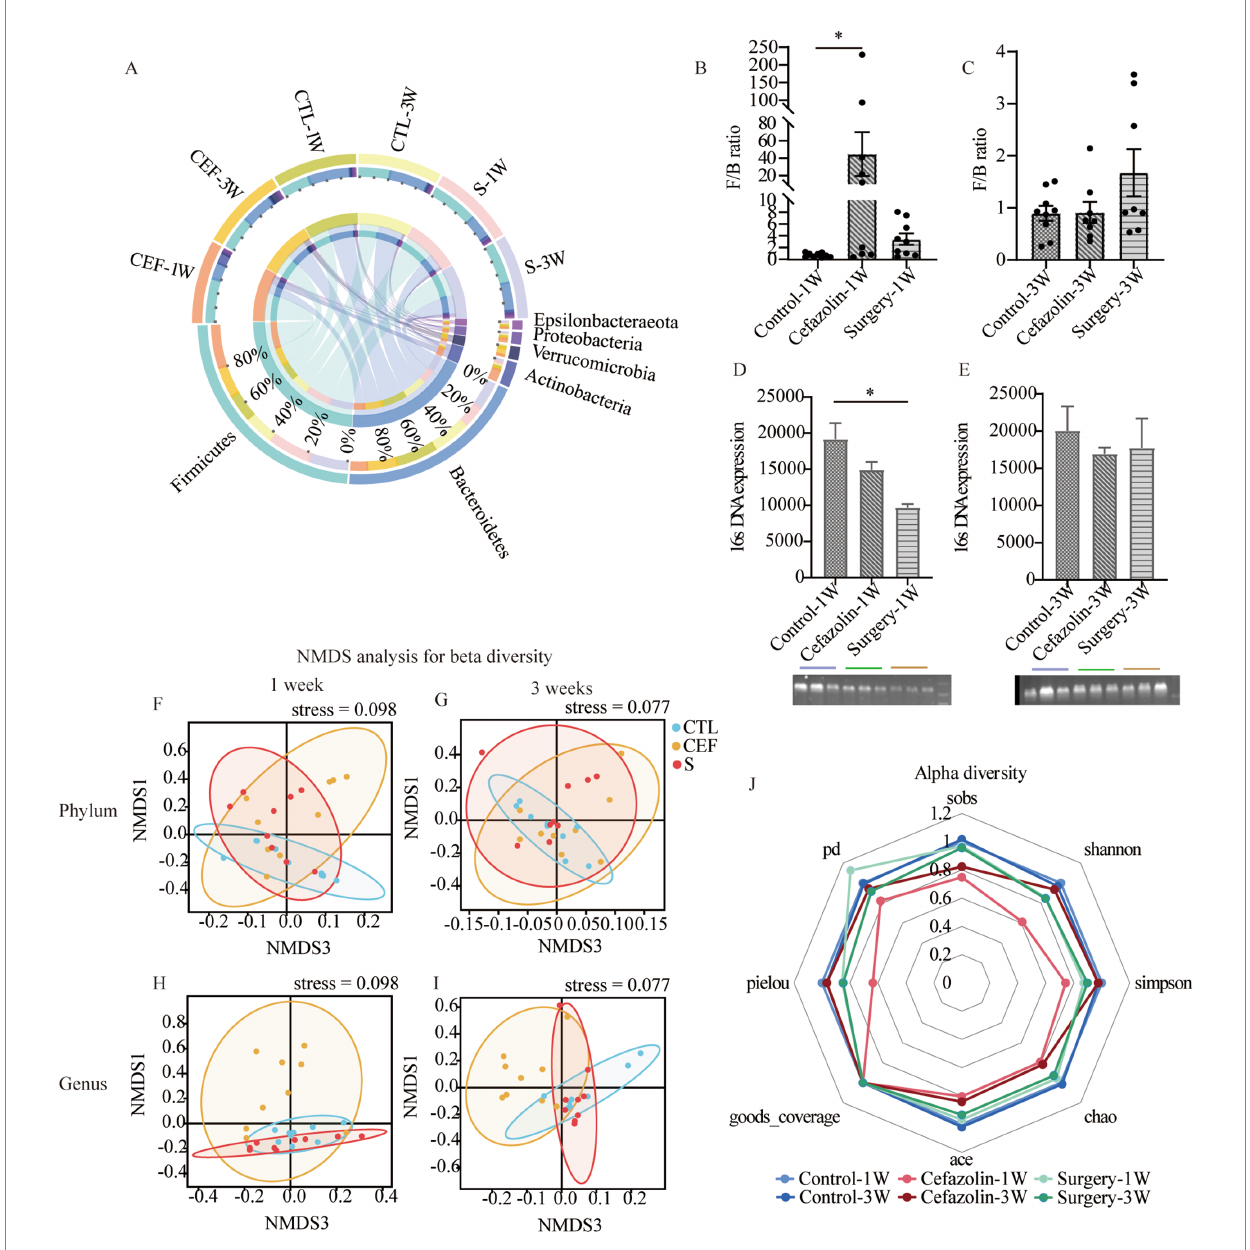
FIGURE 4 Cefazolin-induced and surgery/anesthesia stress-induced gut dysbacteria. (A) The circus graph of the composition of the intestinal microbiome at the level of a phylum of Grp CTL, Grp CEF, and Grp S at 1 and 3 weeks; (B) The F/B ratio of the intestinal microbiome in the level of a phylum of Grp CTL, Grp CEF, Grp S at 1 week; (C) The F/B ratio of the intestinal microbiome in the level of a phylum of Grp CTL, Grp CEF, Grp S at 3 weeks; (D) The 16S rRNA expression of the gut microbiome of Grp CTL, Grp CEF, Grp S at 1 week; (E) The 16S rRNA expression of the gut microbiome of Grp CTL, Grp CEF, Grp S at 3 weeks. (F) Comparison between intra-group and inter-group Bray-Curtis distance of gut microbiome in the phylum level at 1 week of Grp CTL, Grp CEF, Grp S; (G) Comparison between intra-group and inter-group Bray-Curtis distance of gut microbiome in the phylum level at 3 weeks of Grp CTL, Grp CEF, Grp S; (H) Comparison between intra-group and inter-group Bray-Curtis distance of gut microbiome in the genus level at 1 week of Grp CTL, Grp CEF, Grp S; (I) Comparison between intra-group and inter-group Bray-Curtis distance of gut microbiome in the genus level at 3 weeks of Grp CTL, Grp CEF, Grp S. (J) The radar graph of alpha diversity of gut microbiome of Grp CTL, Grp CEF, Grp S at 1 and 3 weeks. Grp, group; CTL, control; CEF, cefazolin; S, surgery; F/B, Firmicutes/Bacteroidetes; NMDS, non-metric multi-dimensional scaling. *Compared with Grp CTL, p <